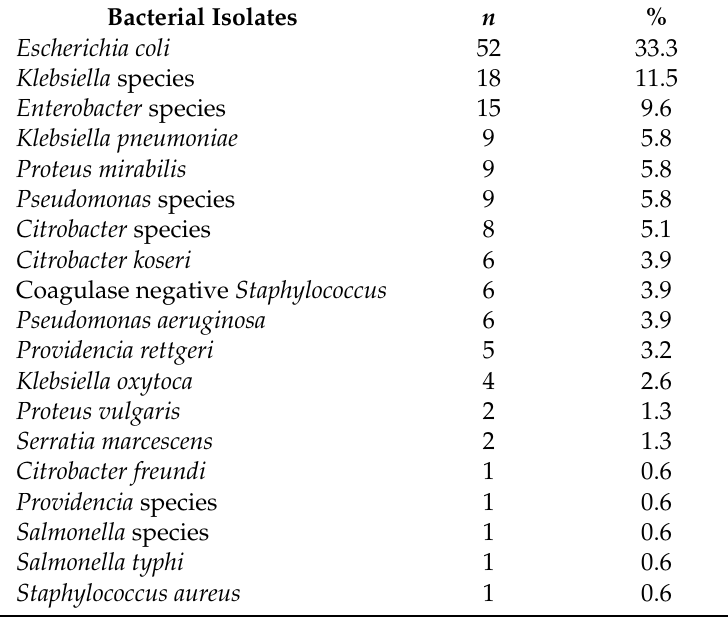
Table 2. The bacteria isolated from urine samples of the bladder outlet obstruction